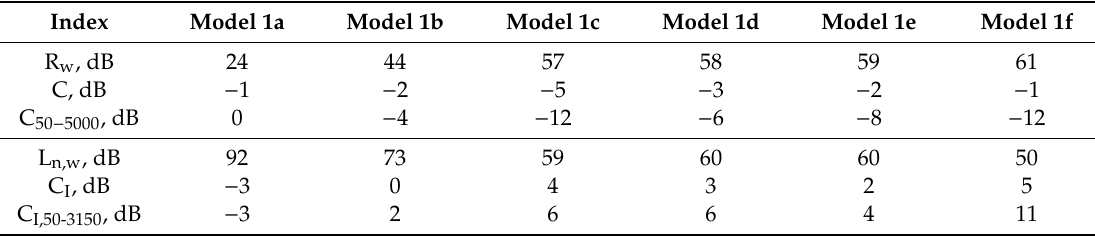
Table 5. Single-number quantities of wooden frame floors.